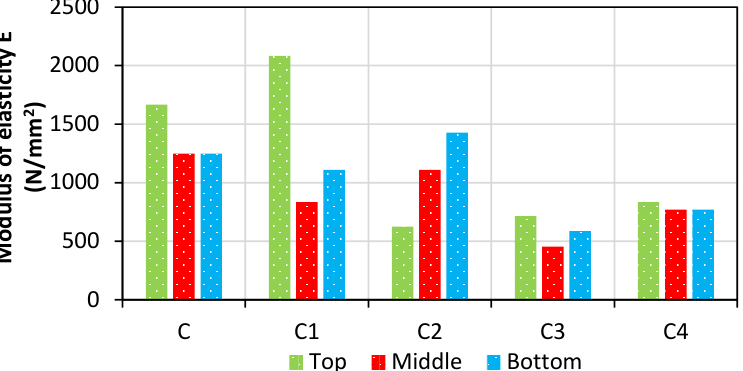
Figure 38. Modulus of elasticity of the specimens at the top, middle, and bottom regions. Using the resulting modulus of elasticity values, the unequal stiffness decrease was quantitatively validated. For the related numerical validation, a prototype model identical to that described in Section 2 was utilized. The specimens C1 and C4’s moduli of elasticity were verified numerically. The portion of the column was divided into the top, middle, and bottom, and their respective modulus of elasticity values were integrated. A 100 kN load was placed to the top of the column, and the supports were designated as pinned. After simulation, the stress was taken into consideration at 200 mm intervals along the whole height of the column. Figure 39 depicts the stress pattern created along the height of column specimens C1 and C4, whereas Figure 40 depicts the comparison of stress along the height of the specimen C1 and C4.